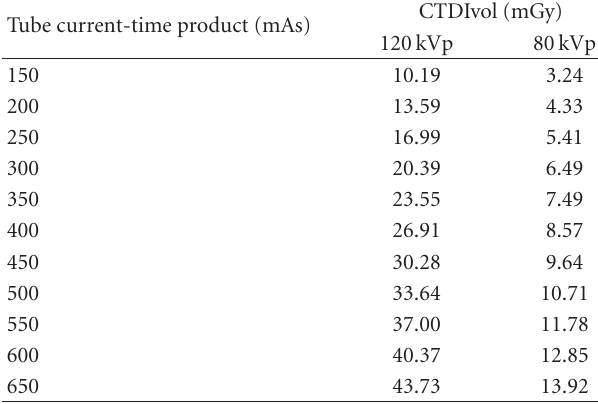
Table 1: The CTDIvol values obtained at each set of acquisition conditions.